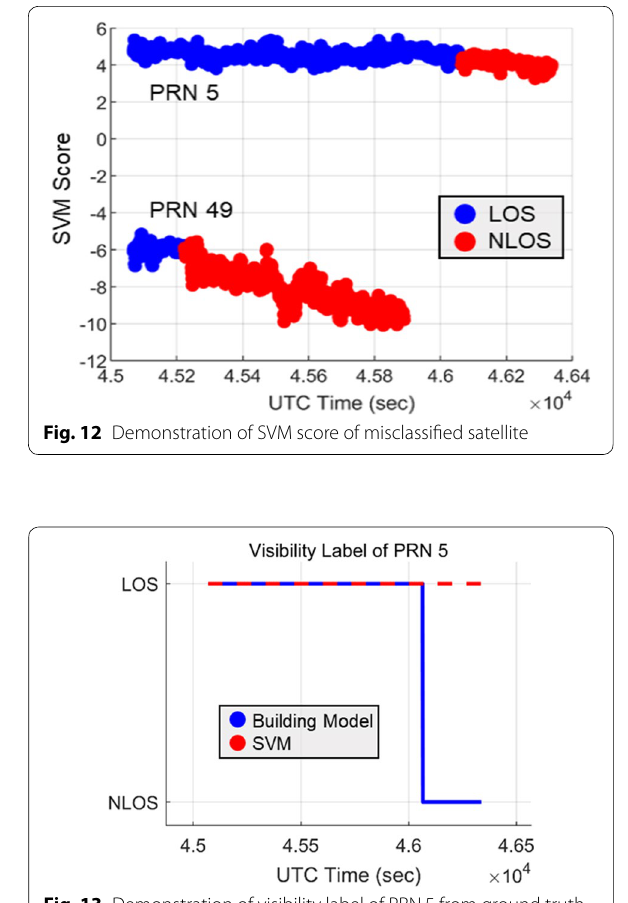
Fig. 13 Demonstration of visibility label of PRN.5 from ground truth and SVM classification